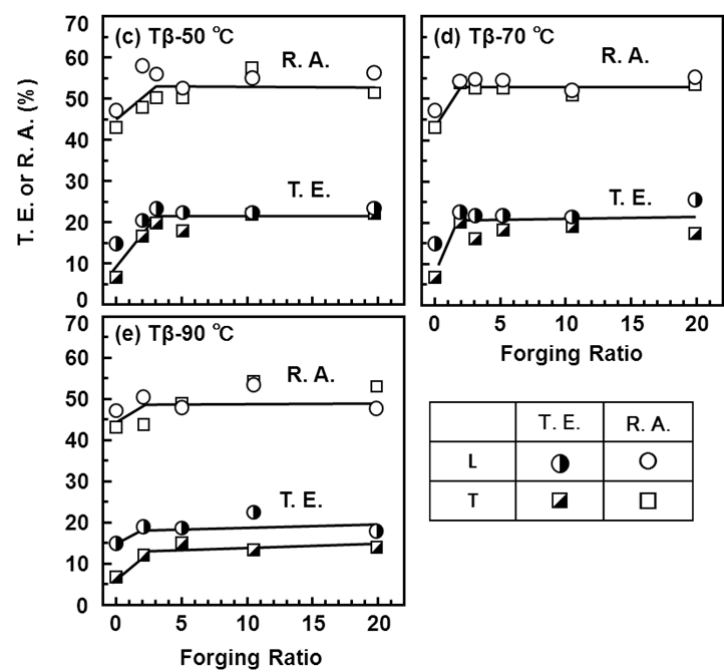
, σ , T.E. and 0.2%PS UTS